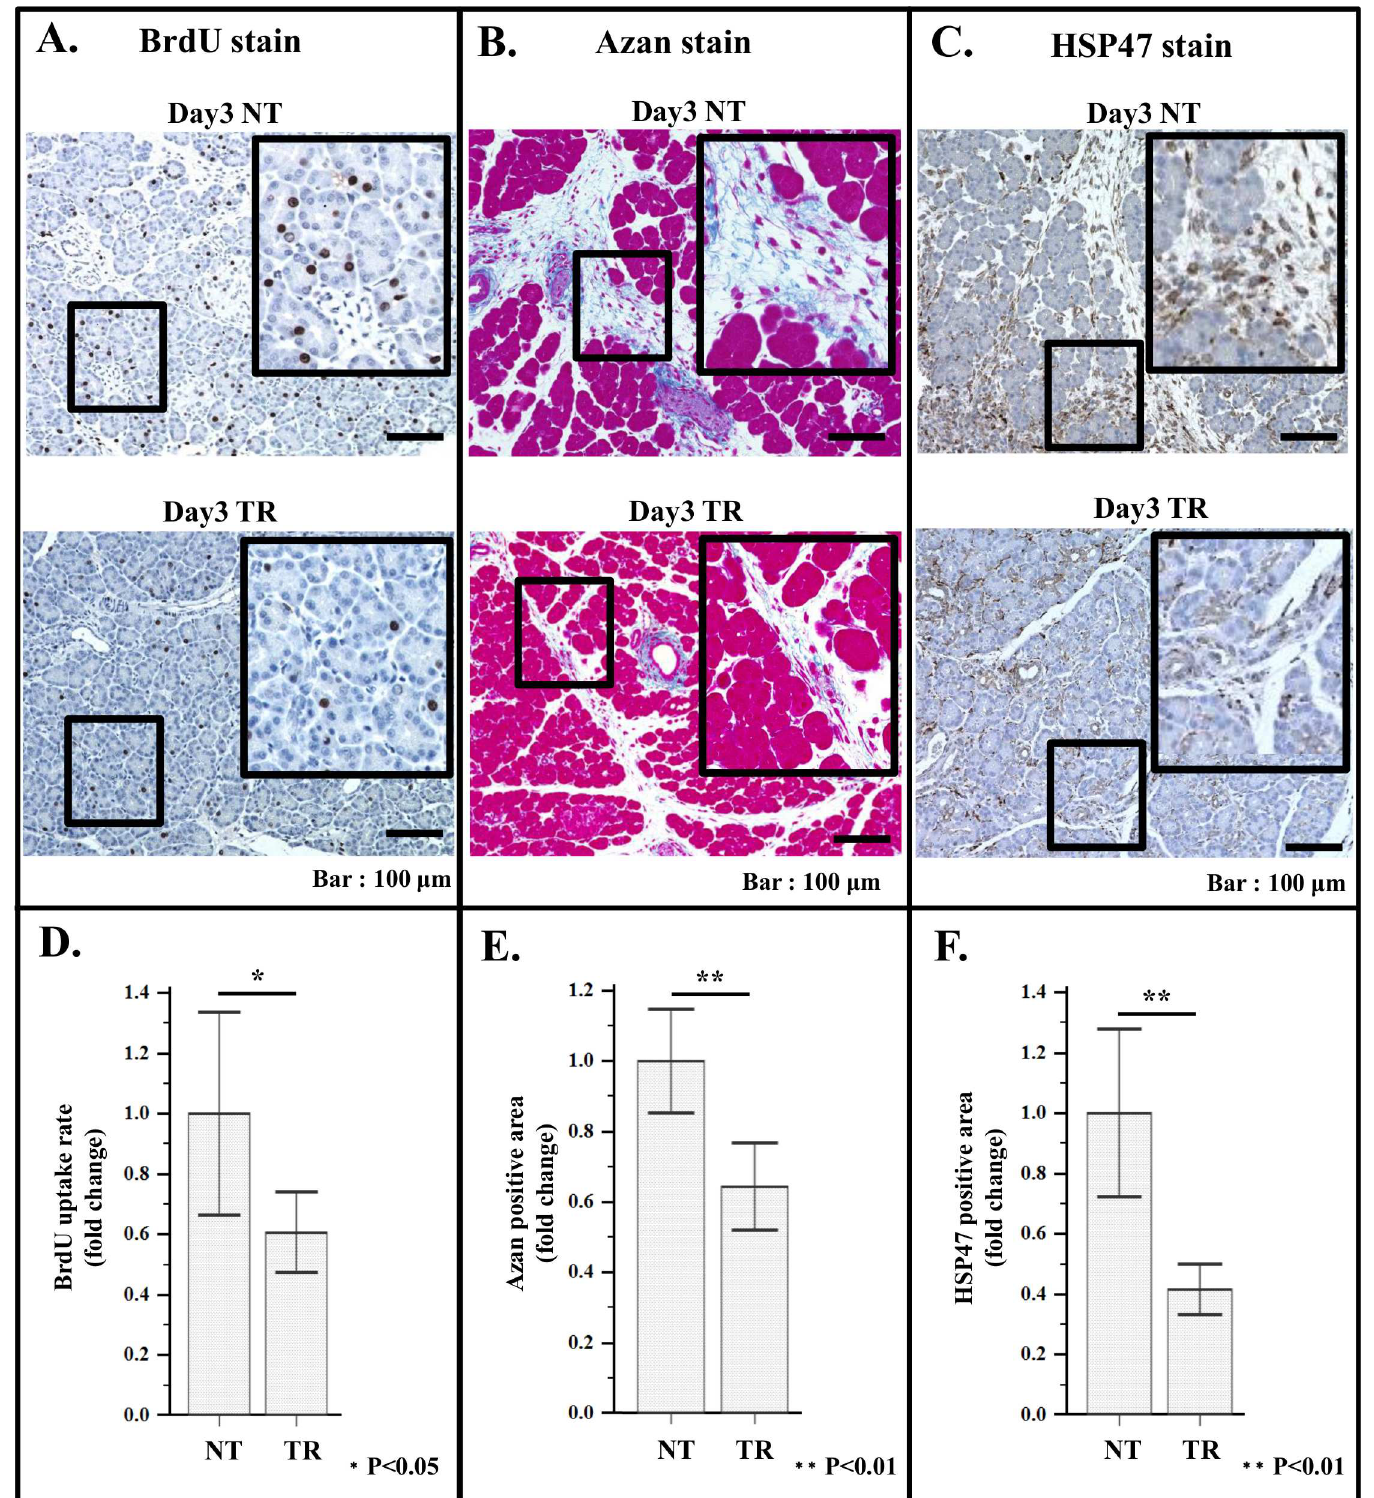
Fig 8. Effect of treatment with VA-liposome siRNA HSP47 on BrdU uptake, ECM deposition and HSP47 positive cell number in duodenal area. Specomenfrom 5 PX rats were analyzed.(A) Representative immune staining images of BrdU uptake by PACs in the remnant pancreas of non-treatedrat (day3 NT; upper panel), and that of treated rat (day3 TR; lower panel). (B) Representative immuno-stainingimages of azan stainingof the remnant